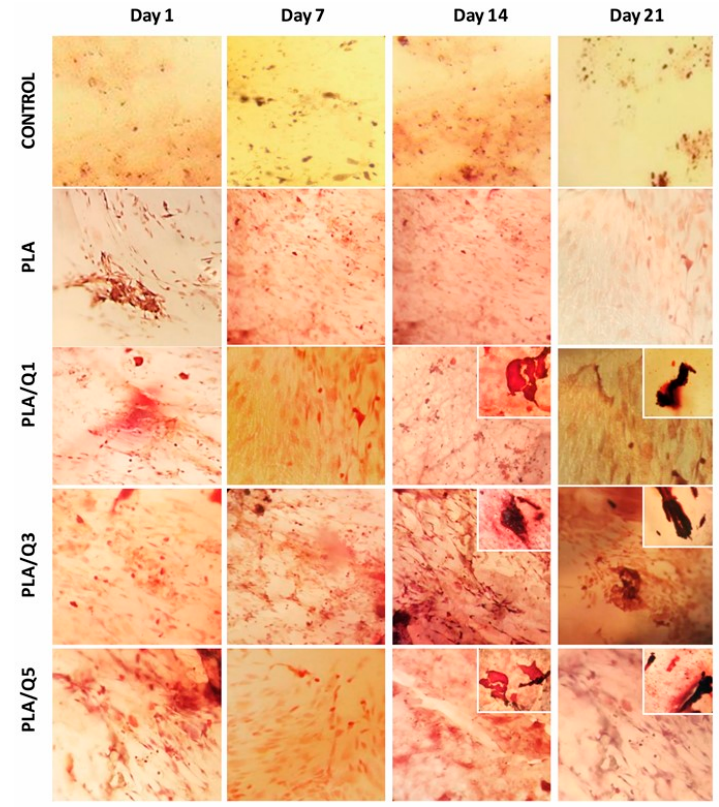
Figure 8. Osteoblasts grown on PLA and composites surfaces and mineralization. Cells were stained with Alizarin Red solution. Images were taken at 20×.